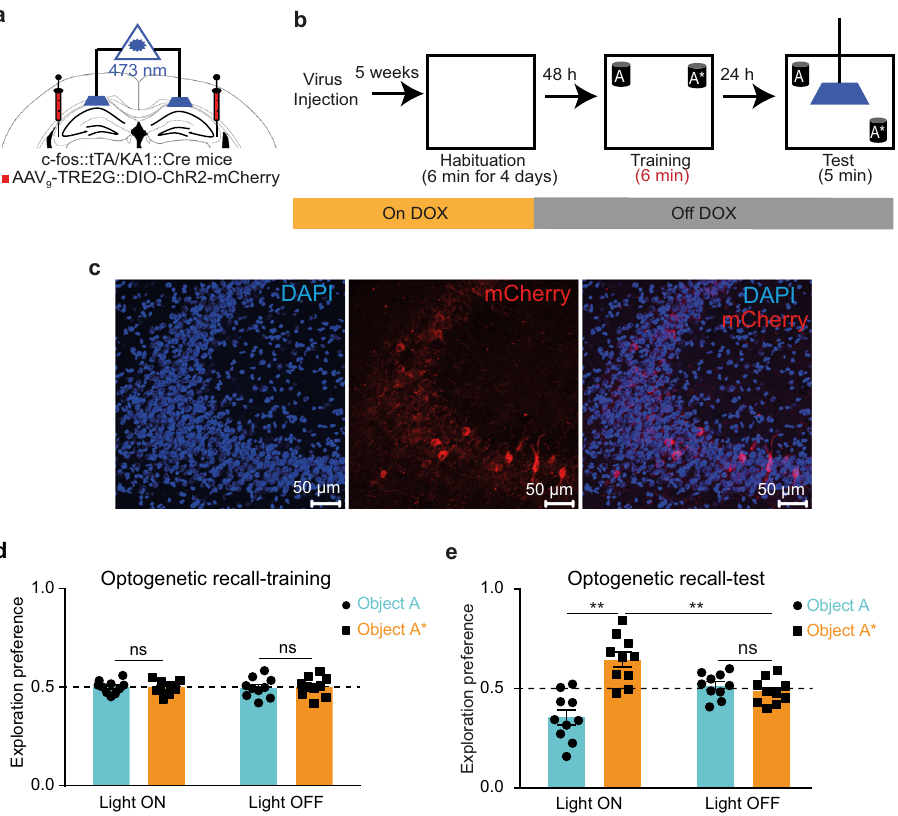
Fig. 2 Optogenetic recall of an STM engram. a Diagram of AAV injection into CA3, guide cannula and optic fi ber placement into CA1. b Experimental design for labelling and optogenetic recall of the NOL STM engram. c Representative section of CA3 showing mCherry protein expression (scale bar = 50 μ m, DAPI: 4 ′ ,6-diamidino-2-phenylindole). Exploration preference for each object during the training ( d ) and the test ( e ) sessions in light ON ( n = 10) vs. light OFF ( n = 10) groups. Comparisons were made using paired student ’ s t-test for comparing object A and object A* in the same group, and unpaired student ’ s t-test for comparing object A* within different groups; ns, not signi fi cant ( P > 0.05), ** P < 0.01. Data are presented as the mean ± a 5 h sleep deprivation immediately after the fi rst training (Supplementary Fig. 7a – c). Contrary to the previous result (Fig. 3d), mice did not discriminate between the two objects